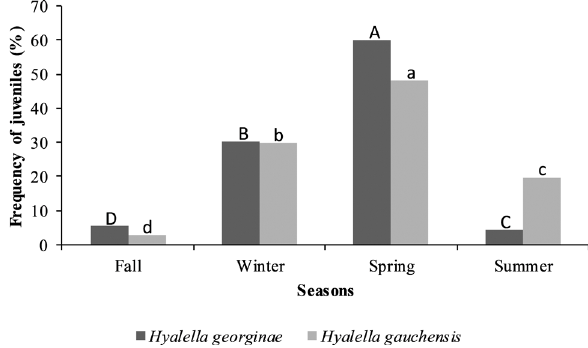
Figure 7. Frequency of ovigerous females of Hyalella georginae and Hyalella gauchensis carrying eggs or juveniles in the brood pouch along season of study, Palmeira das Missões, state of Rio Grande do Sul, Brazil. Capital letters correspond to the comparisons of the frequency of ovigerous females of Hyalella georginae among the seasons of the year and the small letters correspond to the comparisons of the frequency of ovigerous females of Hyalella gauchensis among the seasons of the year. Collumns with at least one letter in common did not differ statistically (p < 0.05).